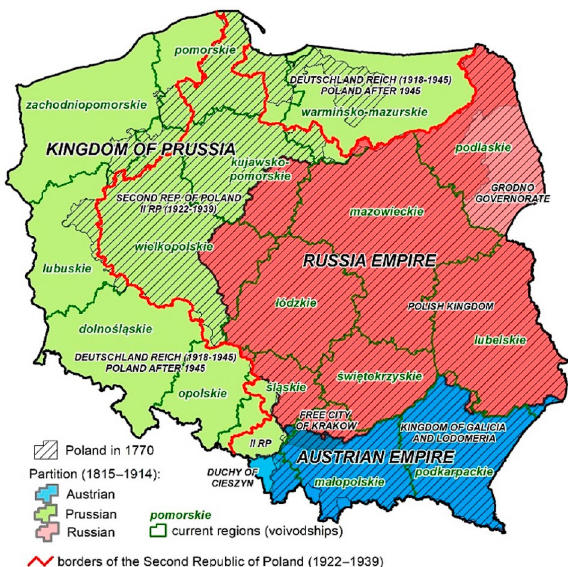
Figure 4. Borders of the partitioned states in the 18th and 19th centuries on the current map of Poland (source: Churski et al., 2021)